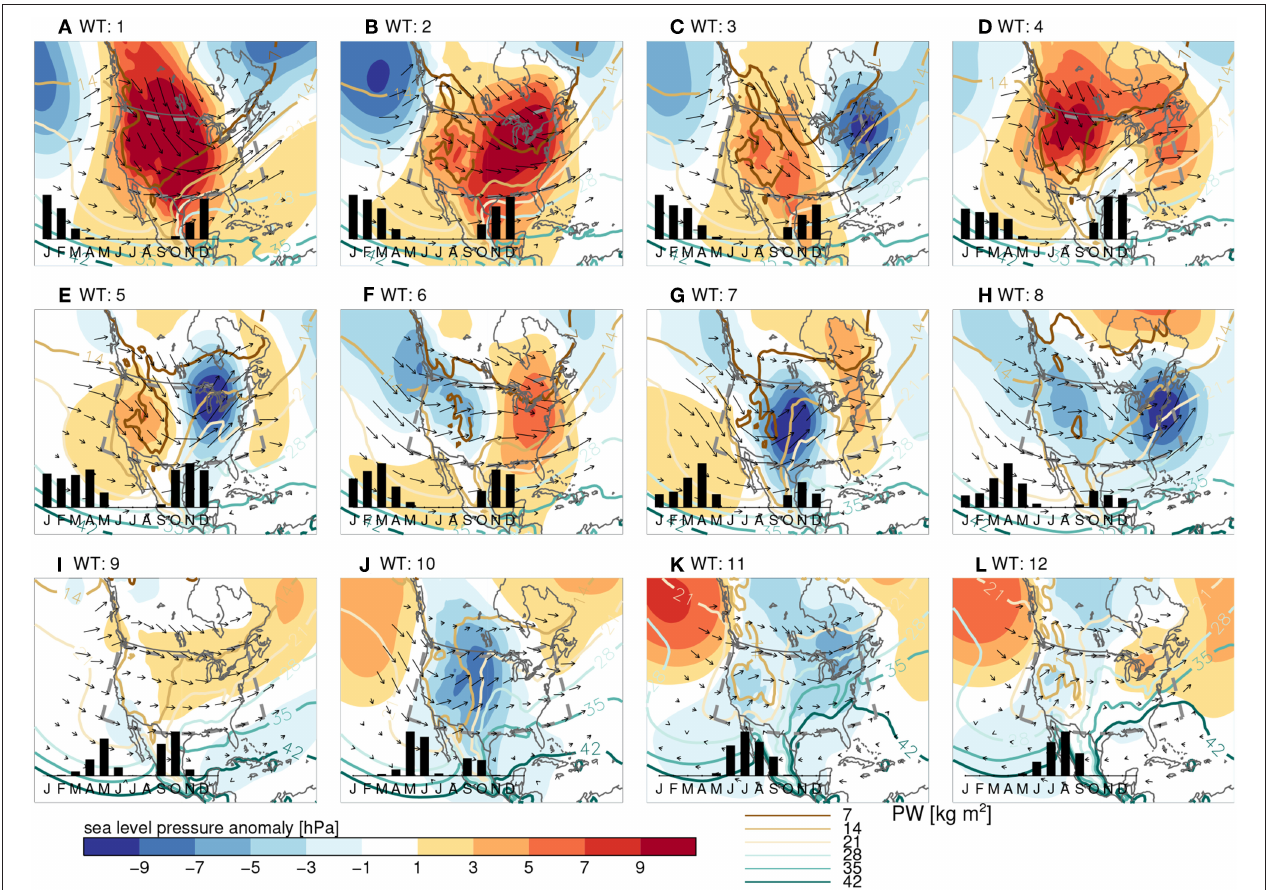
FIGURE 3 | Centroids of the 12 ERA-Interim based WTs (A–L) for the period 1979–2014. Filled contours show sea level pressure anomalies, green contour lines show precipitable water (PW), and arrows show 500hPa wind direction and speed. A histogram of the relative frequency of each WT is shown in the bottom left and the domain used for the WTing is shown in the gray dashed